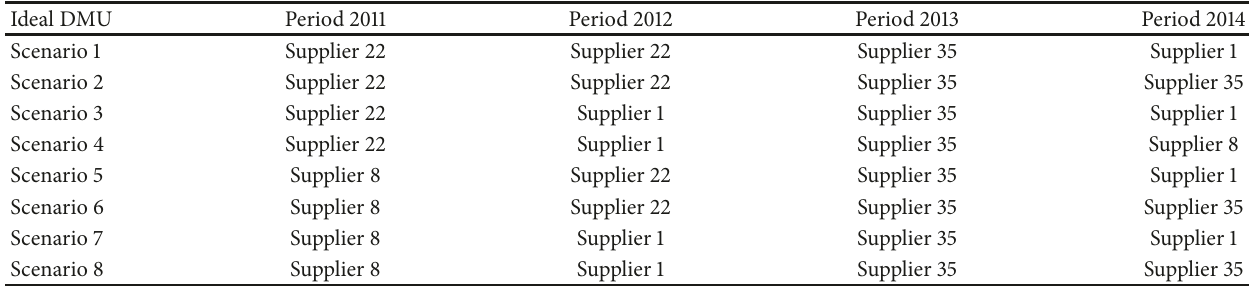
Table 7: Different scenarios for Ideal